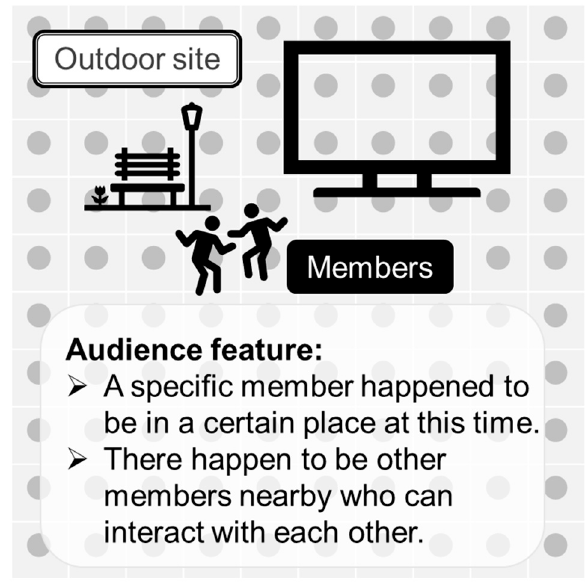
Figure 3. Audience feature in Case 3.